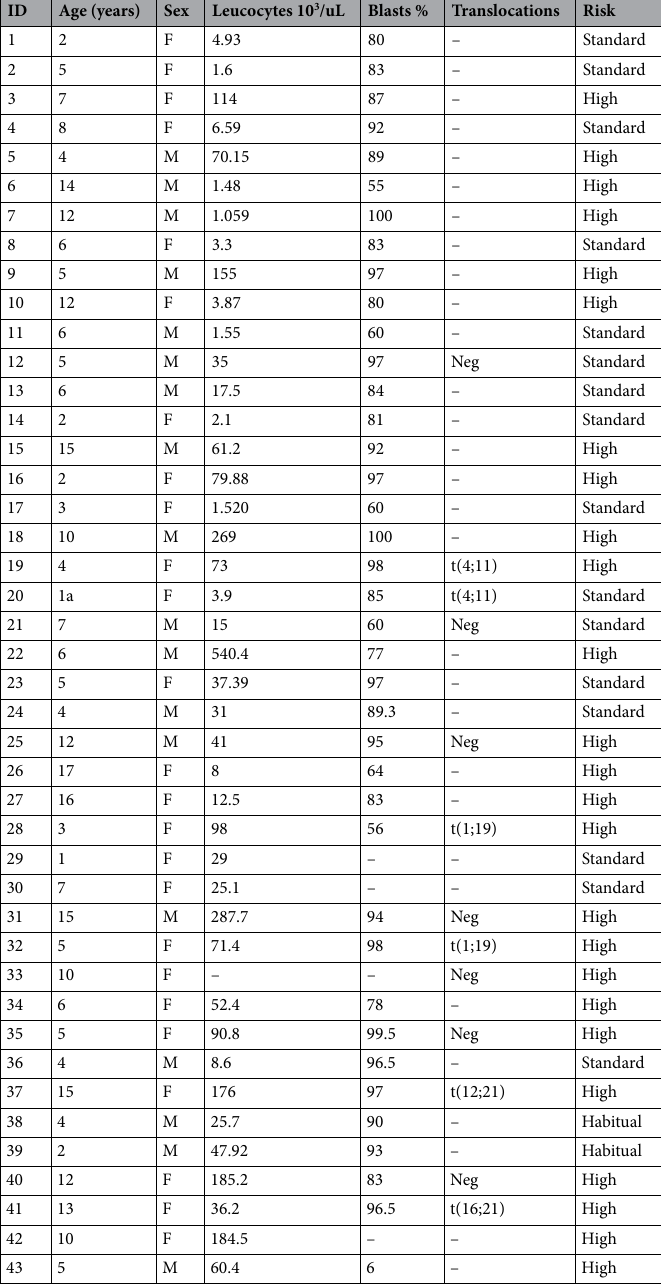
Table 1. Patients and characteristics. Risk stratification is